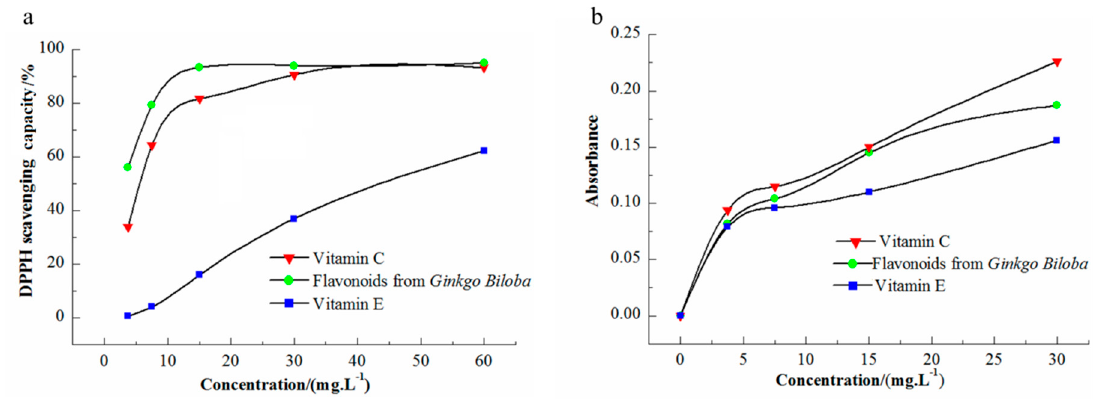
Figure 5. ( a ) 1,1-diphenyl-2-picrylhydrazyl (DPPH) scavenging ability and ( b ) total reducing power of flavonoids from Ginkgo biloba